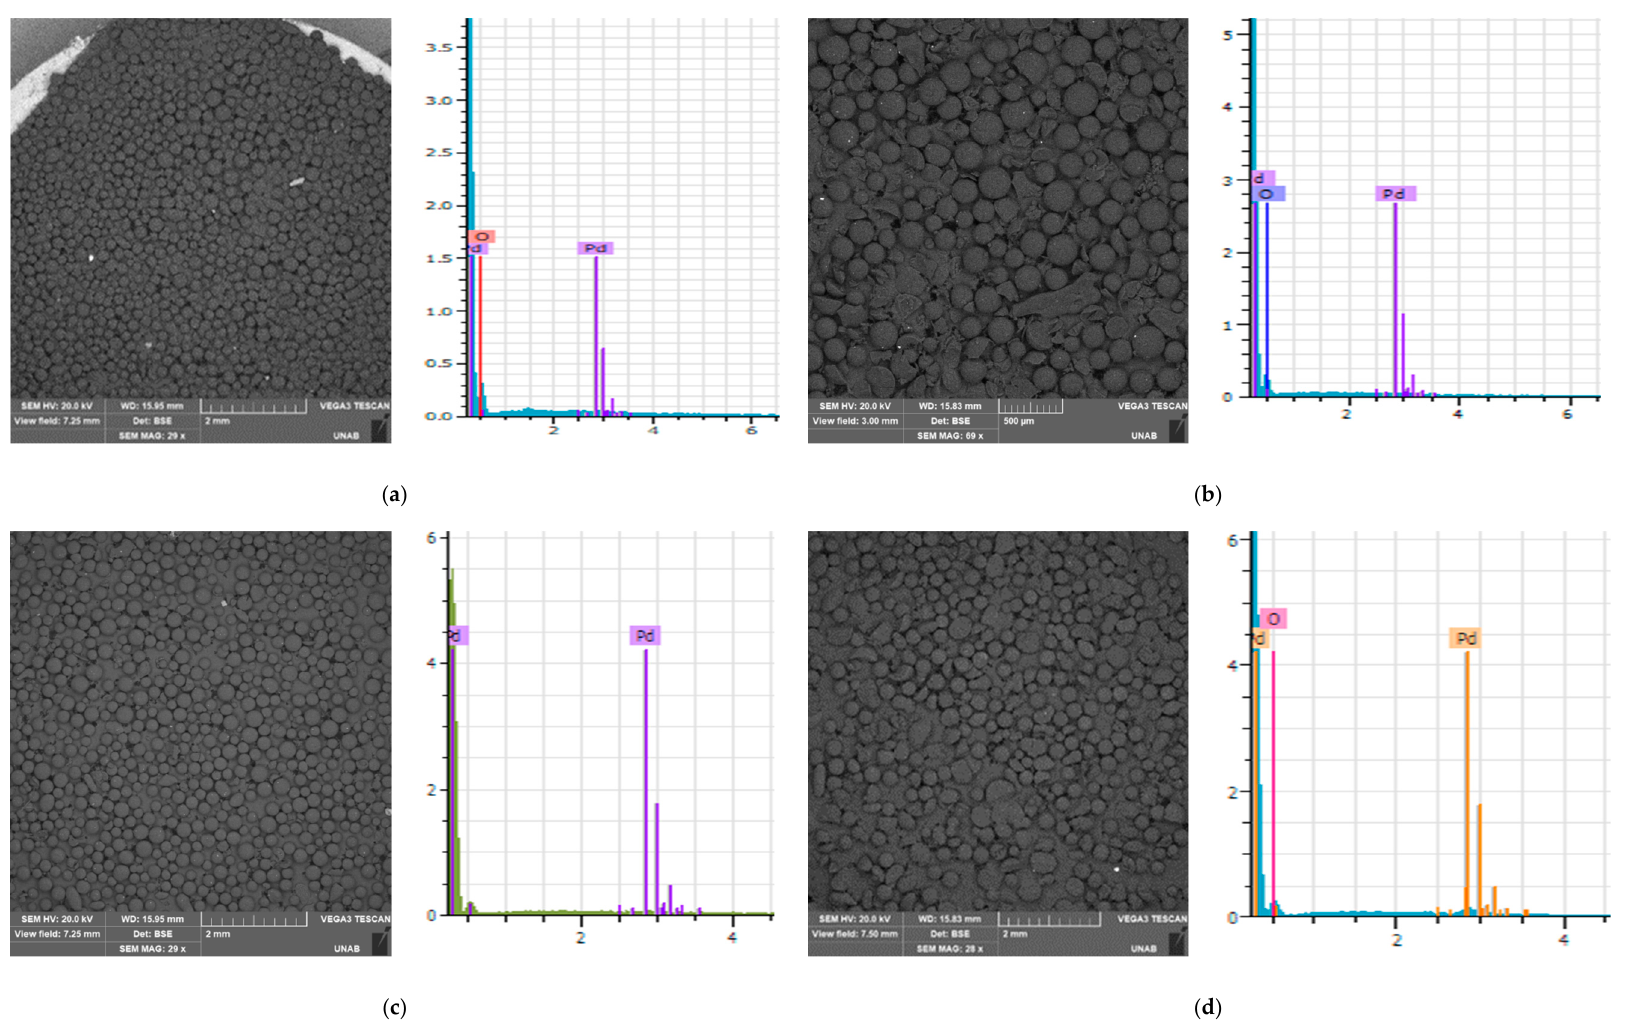
Figure 2. SEM energy-dispersive X-ray spectroscopy (SEM-EDS) micrographs analysis. ( a ) Pd-AS(1)-MA ( b ) Pd-AS(2)-MA ( c ) Pd-AS(5)-MA, and ( d ) Pd-AS(10)-MA.